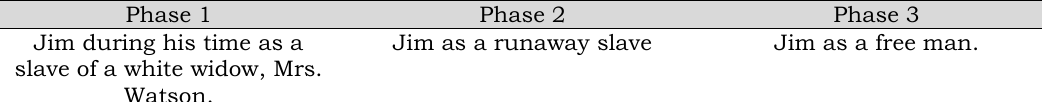
Table 1. Phases of Jim’s life as a